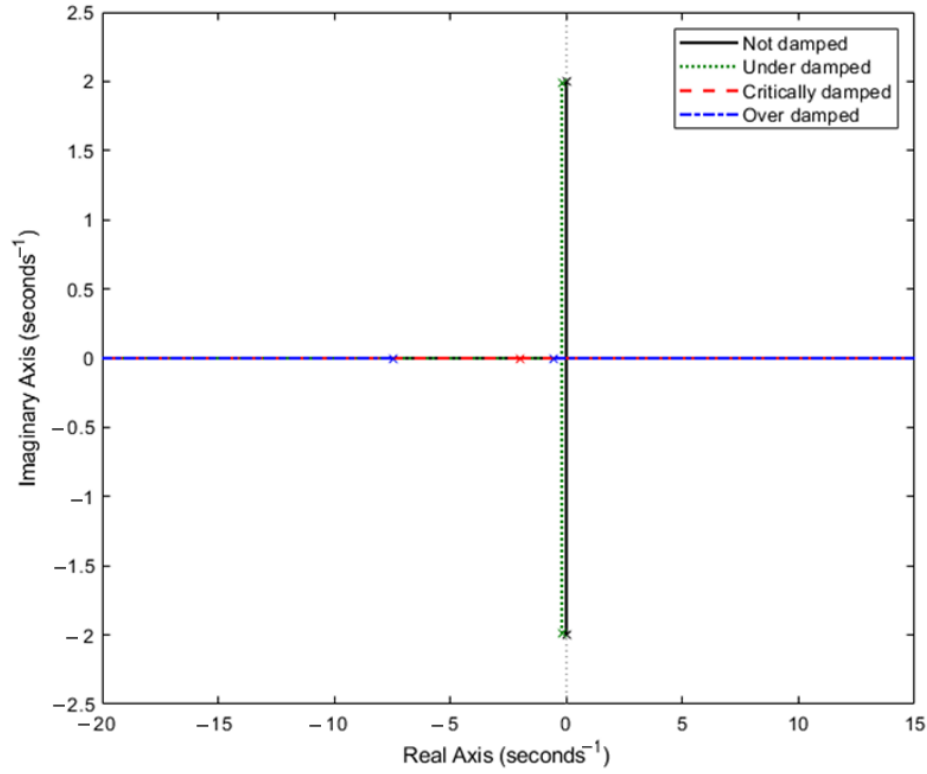
Figure 7. Root locus diagram of the lumped mass dynamic system (Case example 1) for four different arrangements of dominant eigenvalue/pole based on the system’s internal resistance/damping.